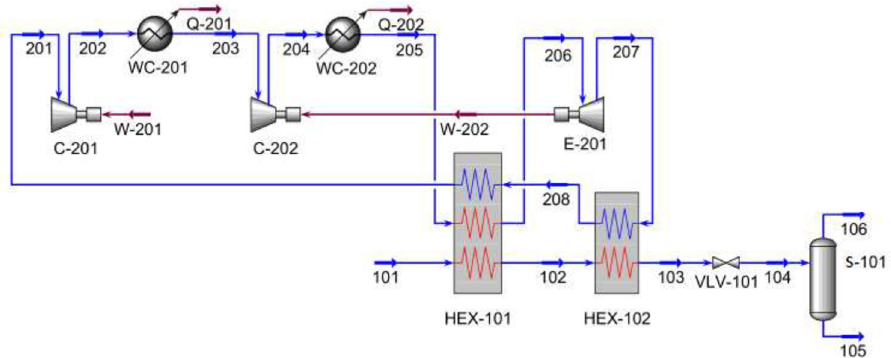
Figure 50. SMR PLNG process [191]. Reproduced with permission from Elsevier (license number